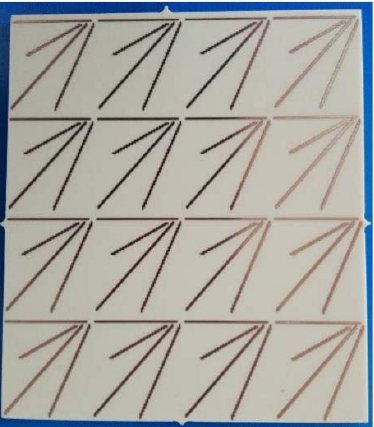
Figure 20. Prototype a chipless RFID sensor for angular rotation monitoring comprising a set of 4 x 4 unit cells with four-dipole elements in each one. From ref.